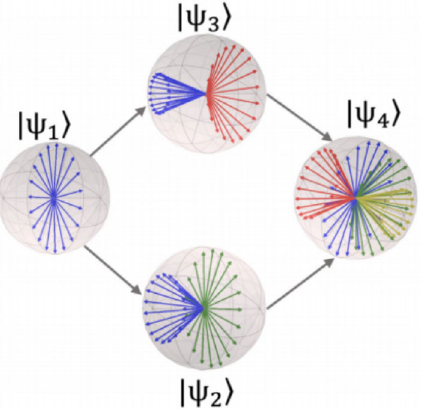
Figure 4. QLBN use quantum states instead of nodes.